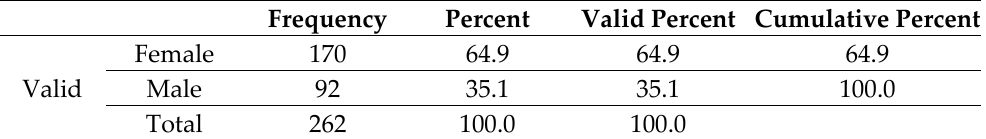
Table 3. Demographic characteristics of participants: gender.